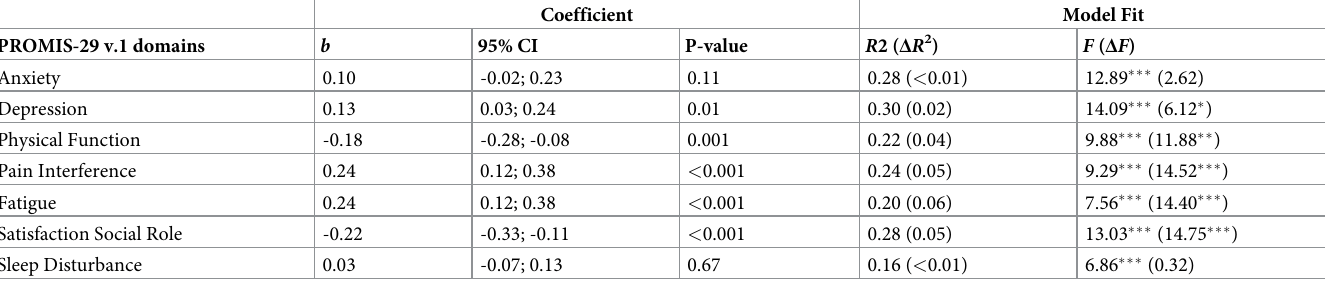
Table 3. Association between percent change in weight and change in PROMIS-29 v 1.0 over 18